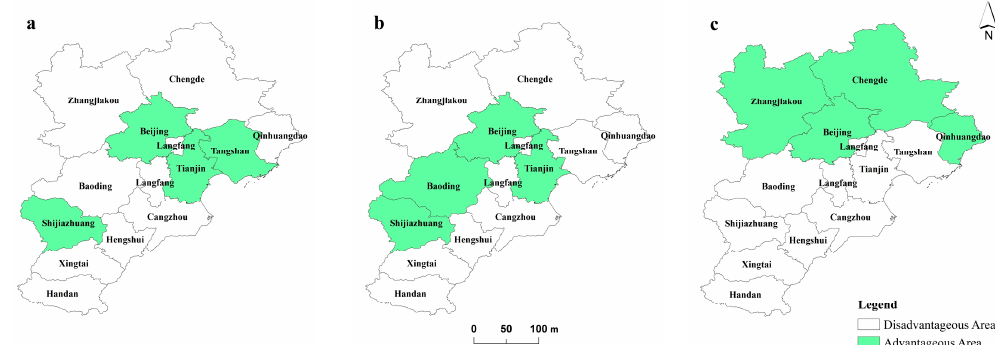
Figure 11. Advantageous cities for each function in the Beijing-Tianjin-Hebei region in 2015, where ( a ) represents the production function, ( b ) represents the living function, and ( c ) represents the ecological function.